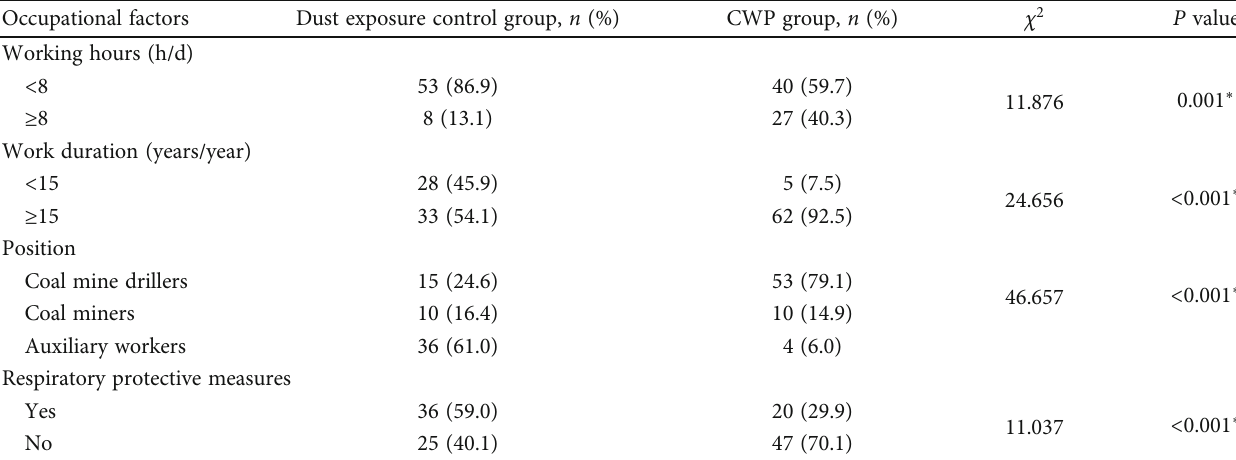
Table 4: Analysis of occupational factor characteristics of coal